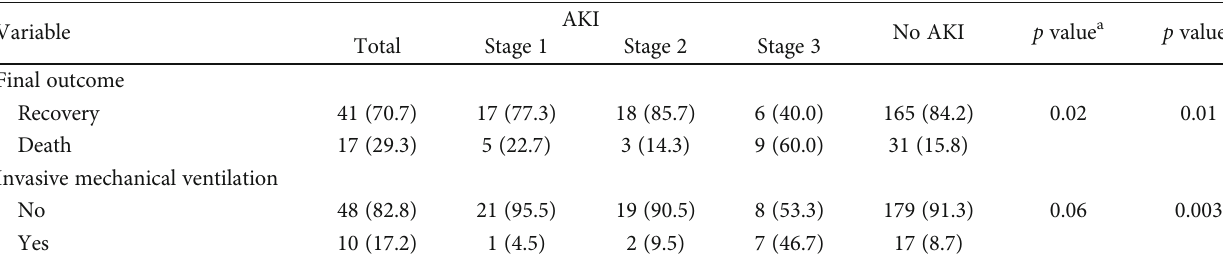
Table 5: Clinical outcomes of patients, by AKI status and AKI